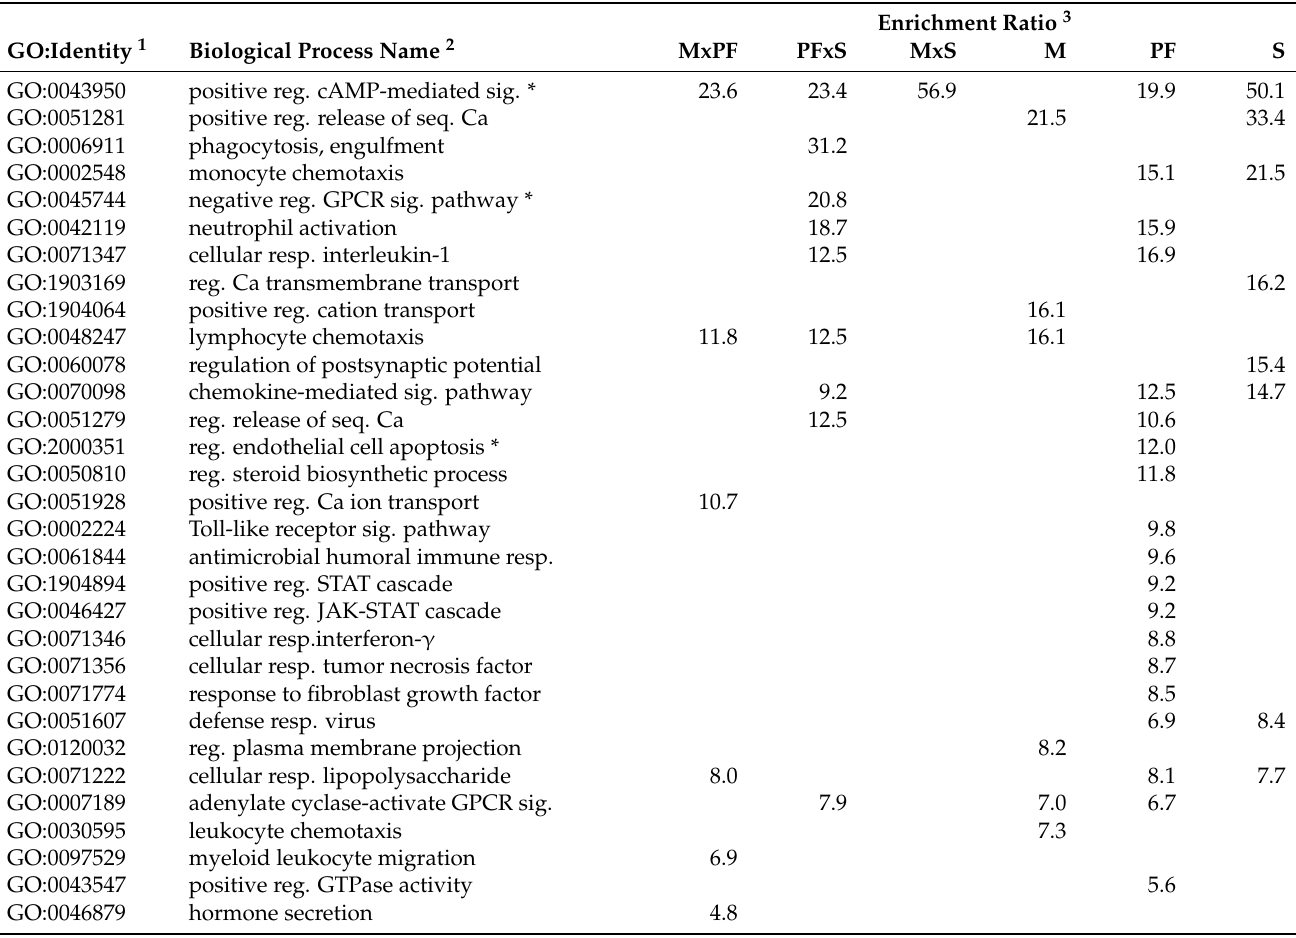
Table 1. Enriched (False Discovery Rate-adjusted p -value < 0.05) Gene Ontology (GO) biological processes identified using the over-representation analysis (ORA) among genes presenting significant (FDR-adjusted p -value < 0.05) maternal immune activation (M), postnatal stress (PF), sex (S), or interaction (x) effects in the